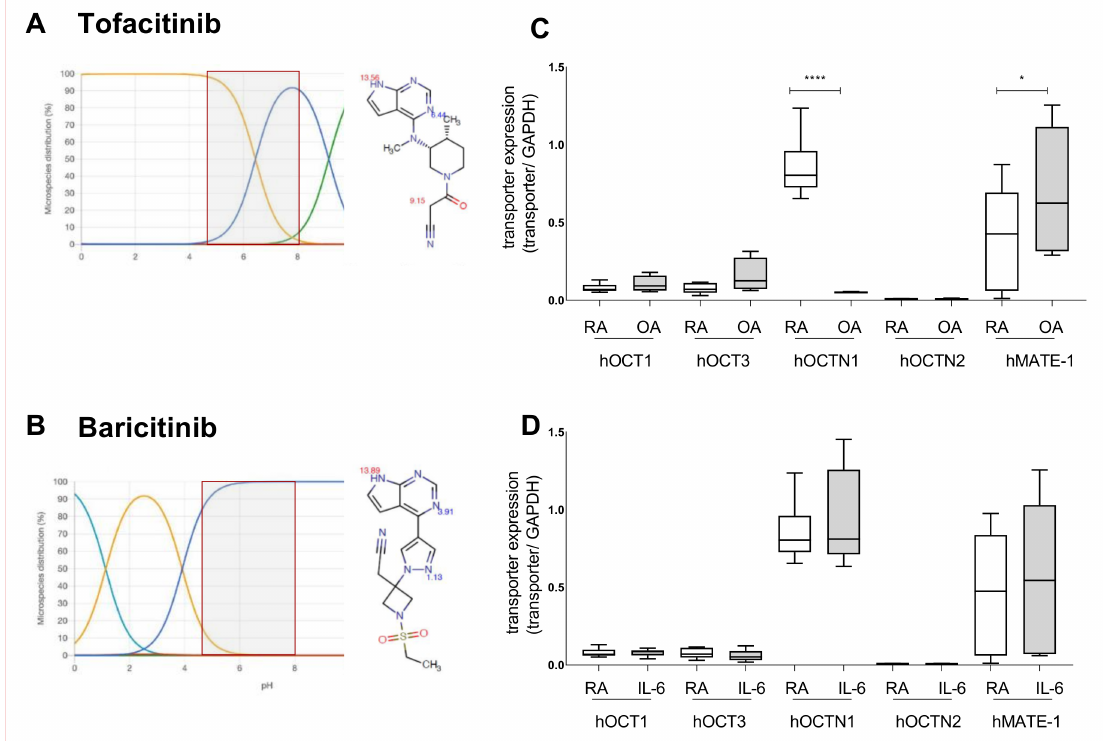
Figure 1. Tofacitinib could be a target for OCT mediated cellular uptake. ( A , B ) pKA prediction for Tofacitinib ( A ) and Baricitinib ( B ). The yellow curves indicate the presence of cationic form, the blue curves indicate the neutral form and the green curves of the anionic form of the substances at the given pH-values. The red boxes indicate the physiological pH-range. ( C ) Quantitative RT-PCR for the expression pattern of OCTs, and hMATE-1 from OASF and RASF. GAPDH was used as housekeeping gene for normalization. ( D ) Quantitative RT-PCR investigating the expression pattern of OCTs, and hMATE-1 in RASF after stimulation with 10 ng / mL IL-6 for 24 h. GAPDH was used as housekeeping gene for normalization. Statistical analyses were performed using an ordinary one-way ANOVA and Sidak correction for multiple testing. *: p < 0.05; ****: p <